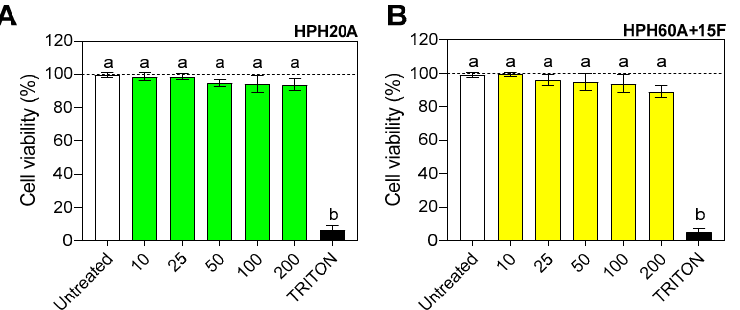
Figure 1. Cell viability (%) of BV-2 cells incubated for 24 h with HPH20A ( A ) and HPH60A+15F ( B ) (up to 200 μ g/mL). Values are presented as the means ± SDs ( n = 3); different letters denote signifi- cant differences among the samples. ( p < 0.05). Control: TRITON.